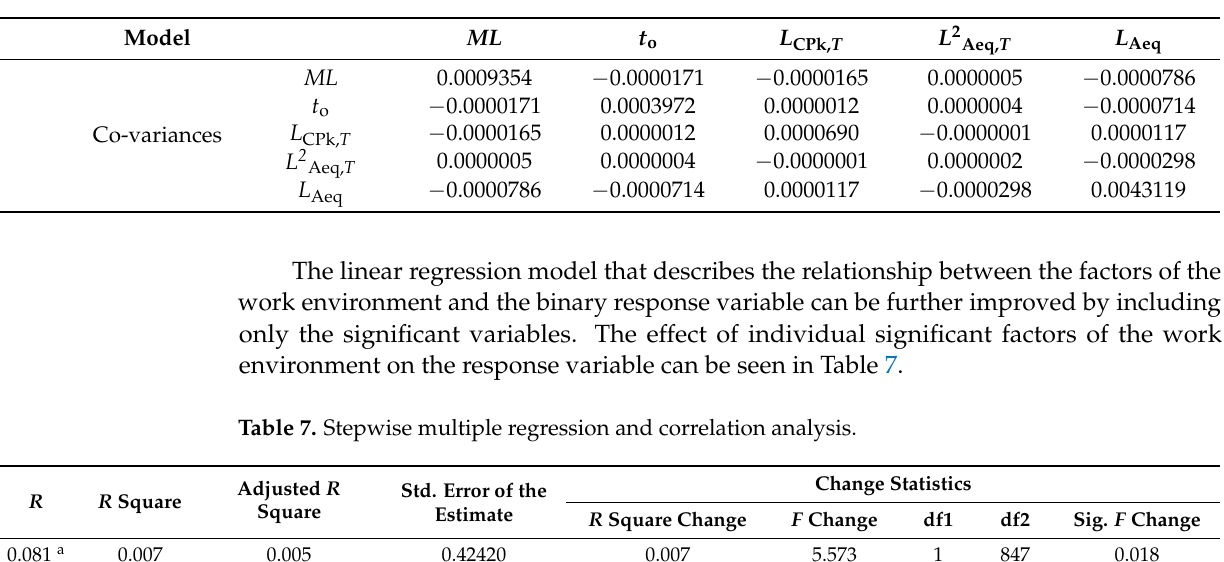
Table 6. Co-variances of the model variables.